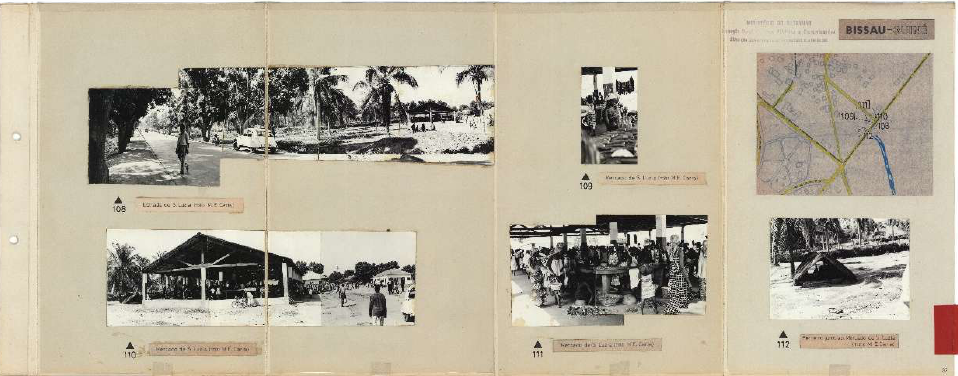
Figure4. Maria Em í lia Caria. “Bissau-Guin é —Documentaç ã o Fotogr á fica recolhida durante aMiss ã o